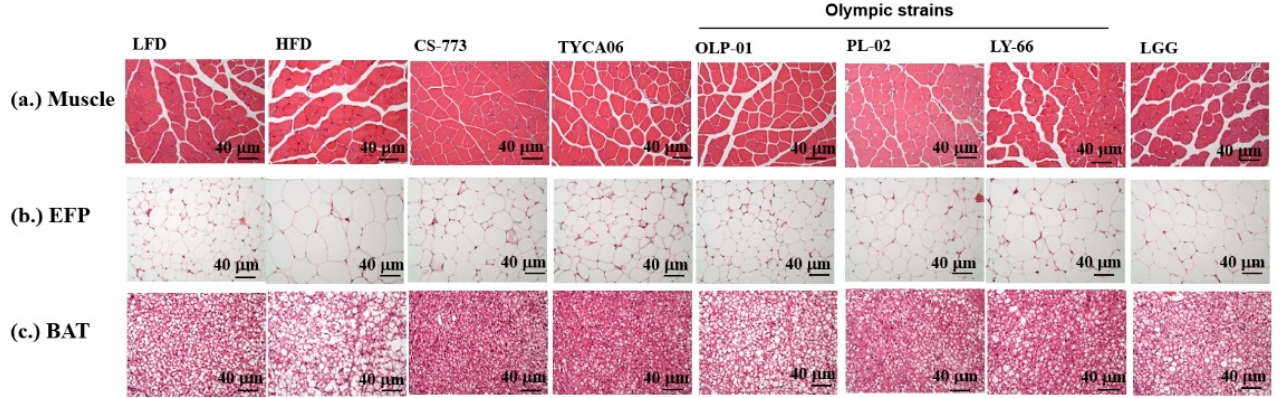
Figure 2. Effects of 10 weeks of probiotic supplementation on histopathology in ( a ) soleus muscle tissue, ( b ) epididymal fat pad (EFP), and ( c ) brown adipose tissue (BAT) in mice. Tissue sections were processed with hematoxylin and eosin stain (magnification, 200×; bar, 40 µm). All probiotic-fed groups, except for the TWK10 group, showed significant improve- ments in the running test relative to the control groups. The LPL-28, PL-02, LY-66, TYCA06, CS-773, BLI-02, and MP-108 groups exhibited longer running endurance than